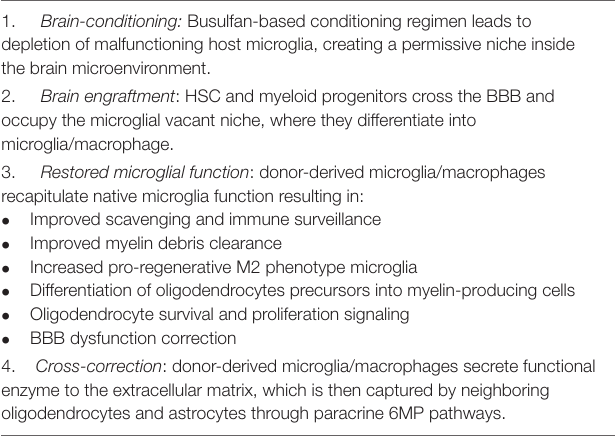
TABLE 1 | Events that result in brain repair with allogeneic hematopoietic stem cell transplantation in Inborn Errors of Metabolism with neurological involvement. 1. Brain-conditioning: Busulfan-based conditioning regimen leads to depletion of malfunctioning host microglia, creating a permissive niche inside the brain